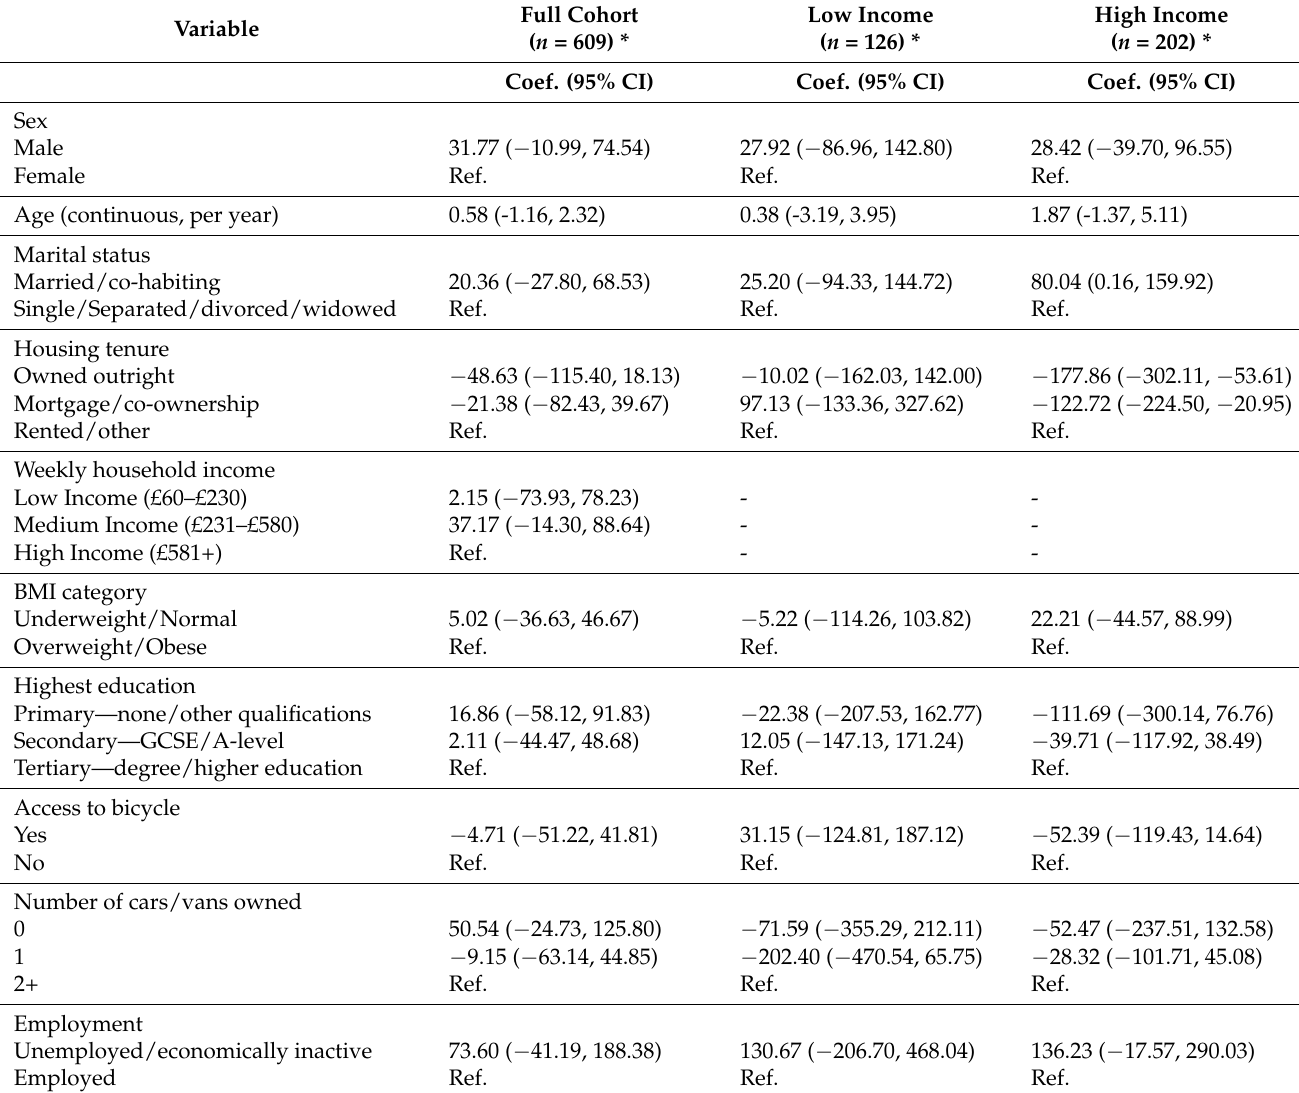
Table 4. Multiple linear regression of socio-demographic, health, environmental and psychological associations of those that engage in ‘some‘ active travel (continuous data) for full cohort and by low and high